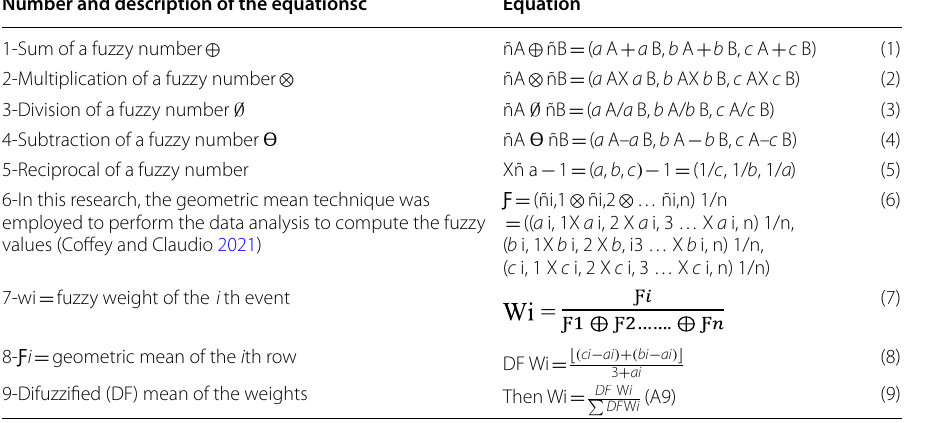
Number and description of the